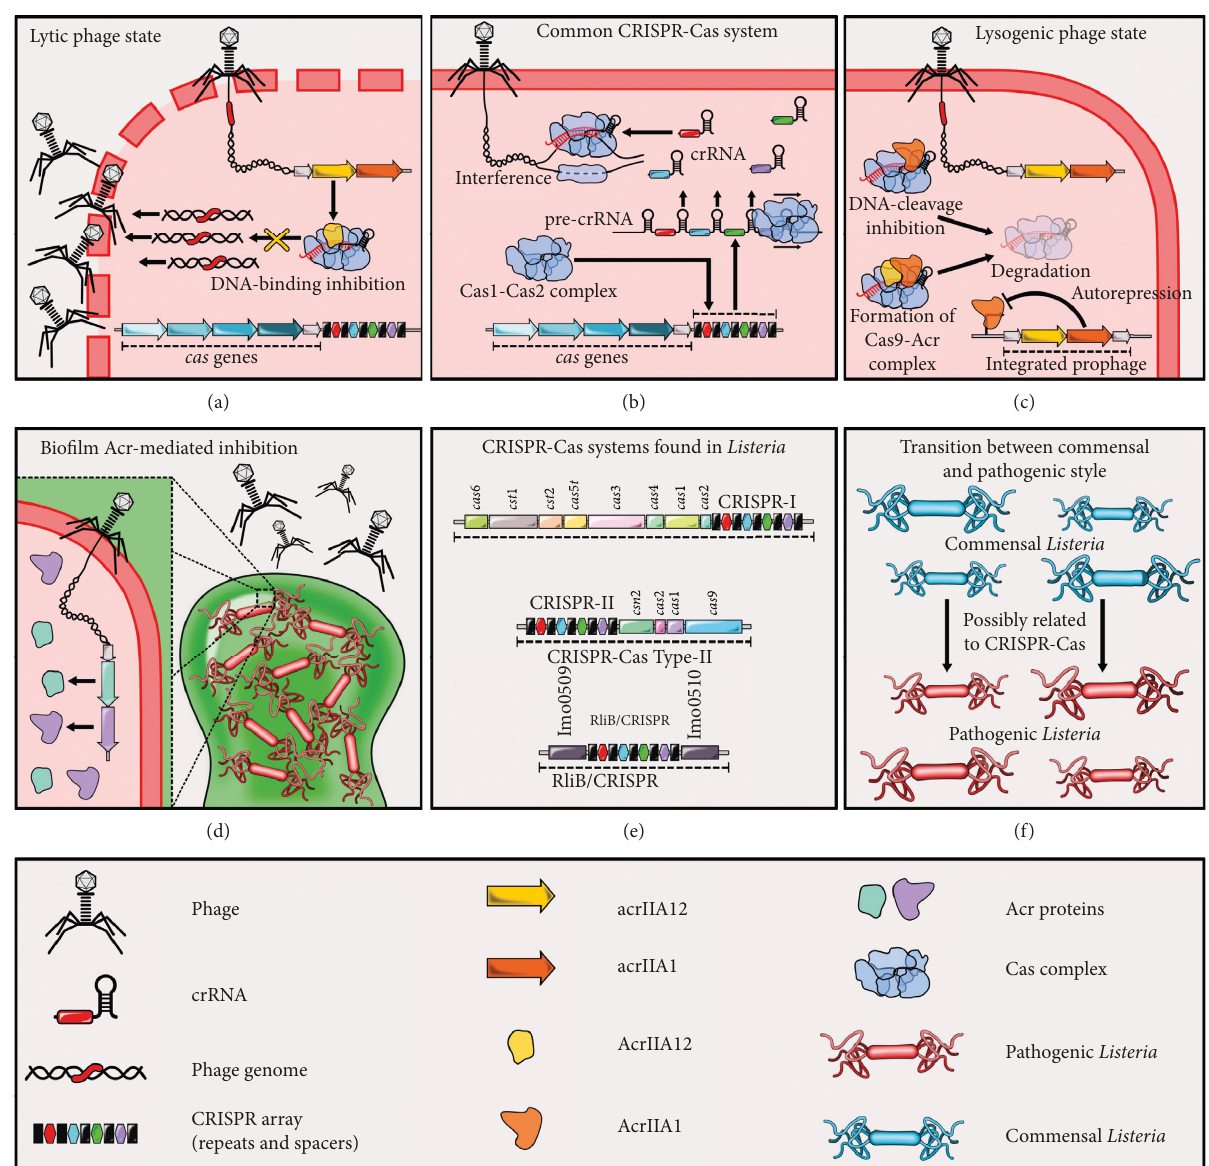
Figure 1: Summary of CRISPR-Cas system and potential applications in Listeria . Influence of AcrIIA1 and AcrIIA12 proteins on (a) lytic and (c) lysogenic cycle of Listeria bacteriophages. (b) Overview of common CRISPR-Cas mechanism of action. (d) Possible application of Acr proteins mediating biofilm formation and control. (e) Most common CRISPR-Cas systems in Listeria. (f) CRISPR-Cas as a potential virulence factor in